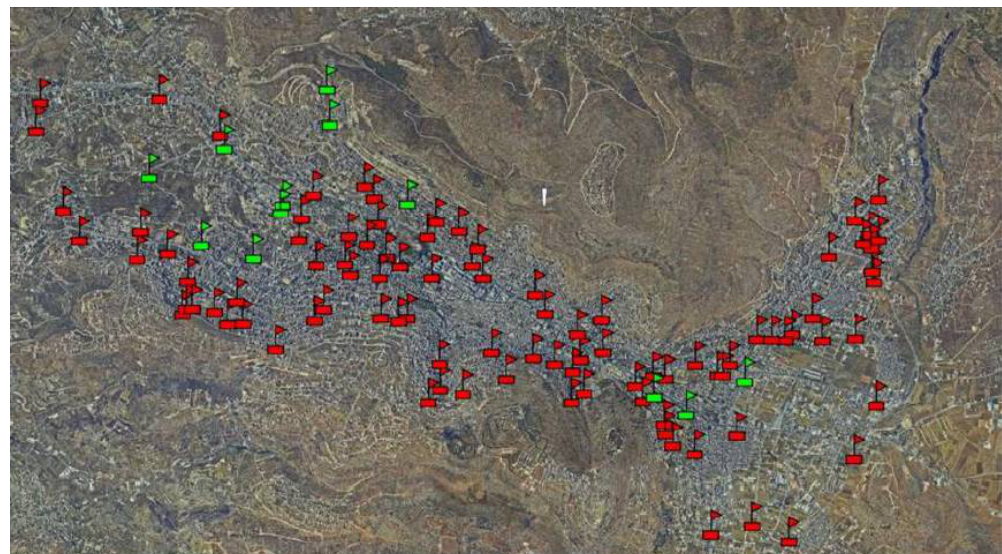
Figure 6. Traffic volume measuring locations.